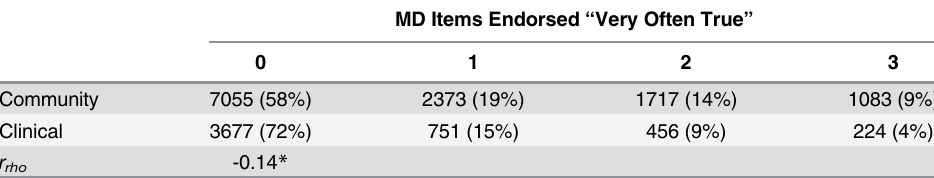
Table 3. Associations between MD Subscale Scores and Community versus Clinical